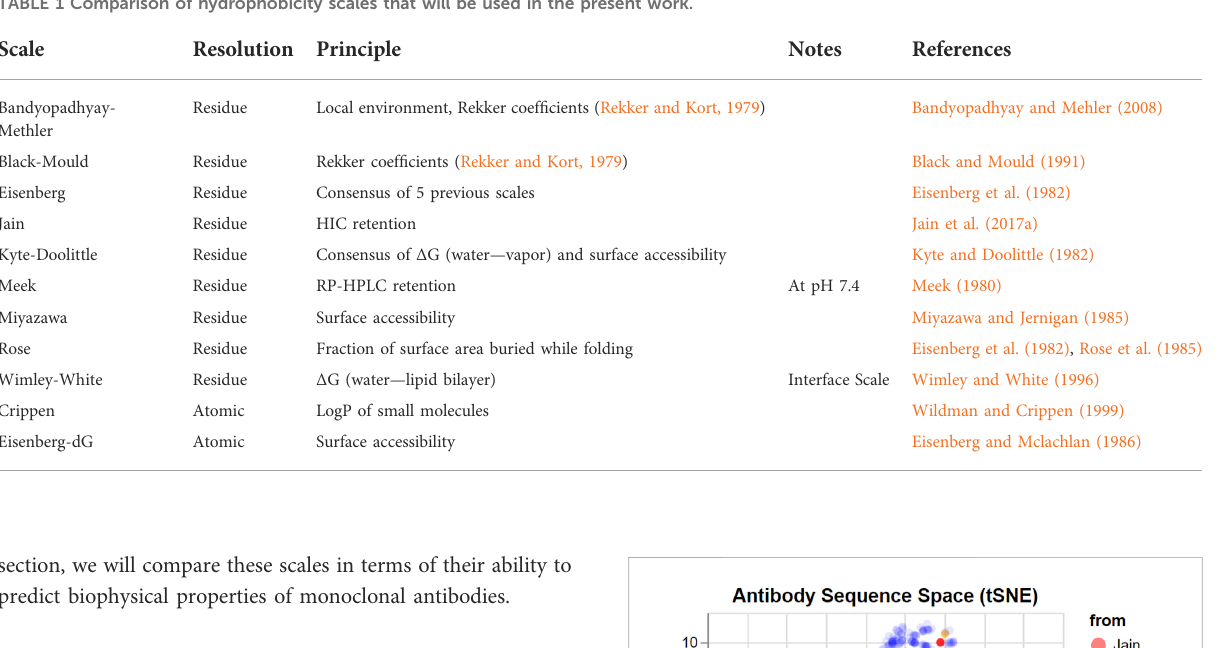
TABLE 1 Comparison of hydrophobicity scales that will be used in the present work.